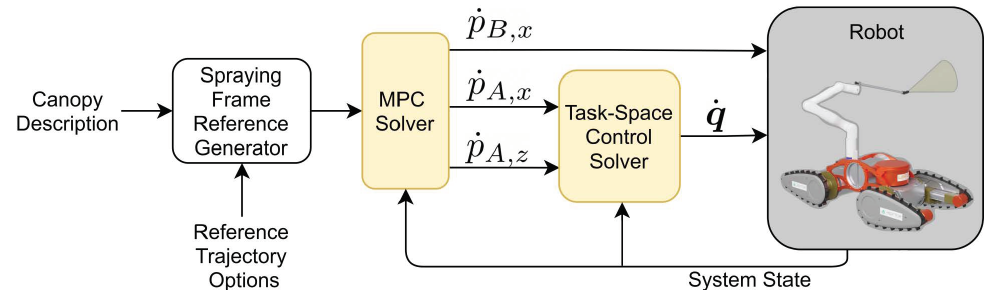
Figure 3. Overall system control diagram. The trajectory of the reference spray frame is generated based on the canopy description and used as input to the MPC solver. The MPC solver provides the velocity of the mobile base along the row and the velocities of the robot arm in the task space. The task space control solver converts the desired velocities in the task space into joint velocity commands ˙ q .